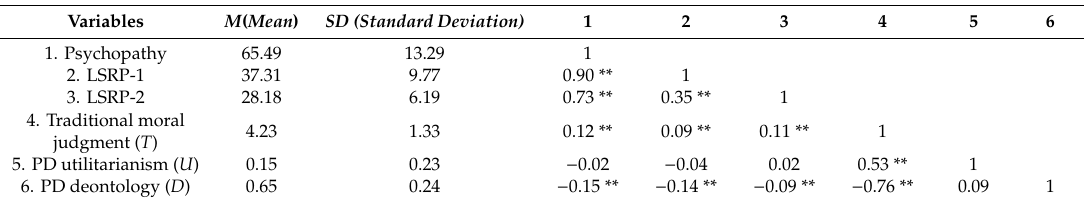
Table 1. The study results between the variables of the mean, standard deviation, and Pearson binary correlation coe ffi cient ( N = 869).